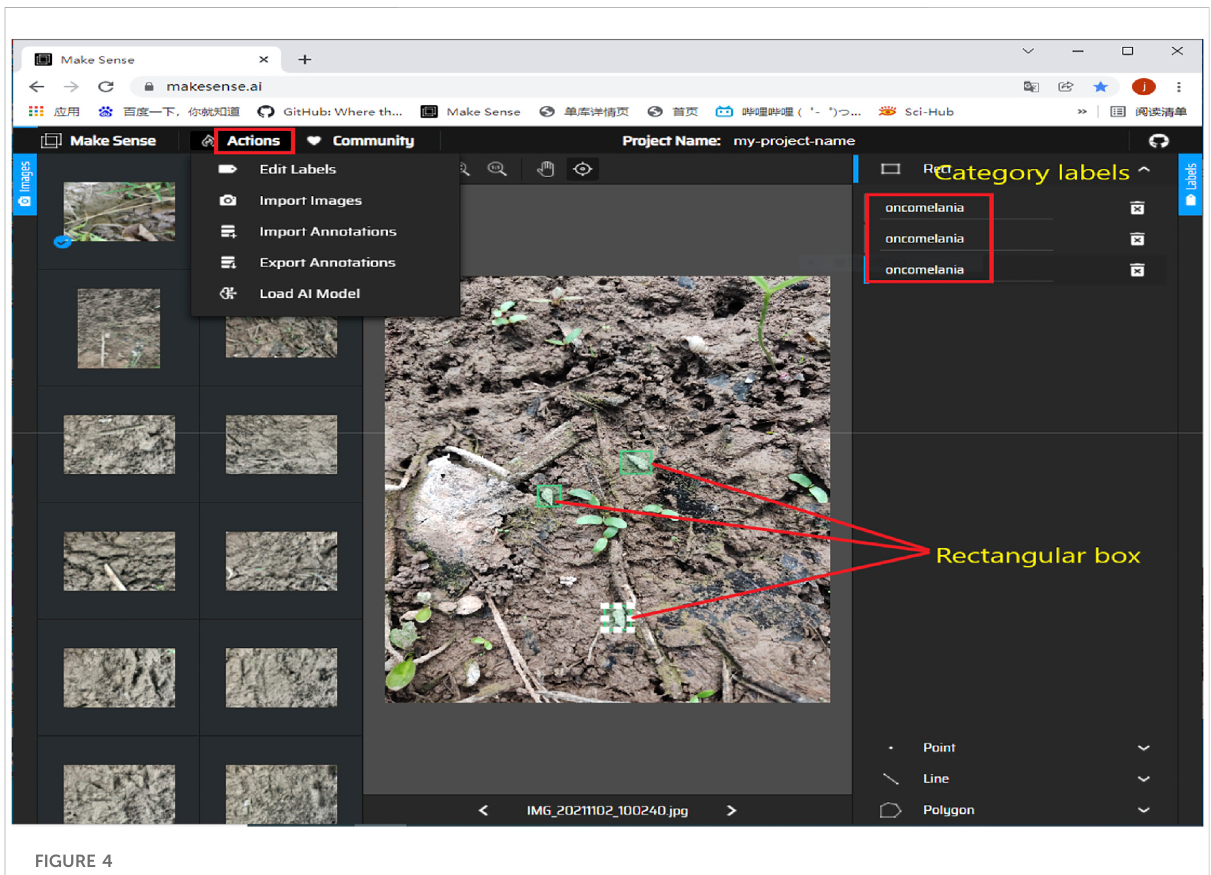
FIGURE 4 Example of data set